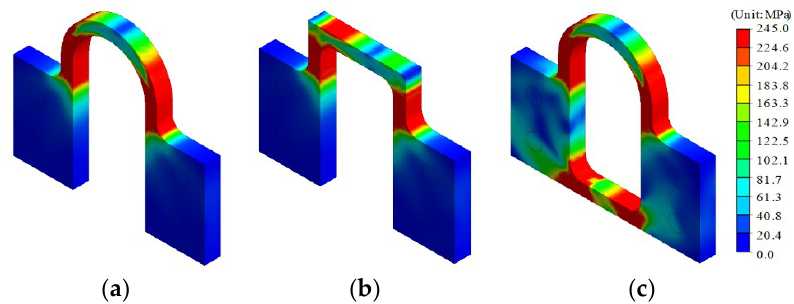
Figure 11. Stress distribution of steel dampers obtained from FE analysis: ( a ) SD1; ( b ) SD2; ( c ) SD3.